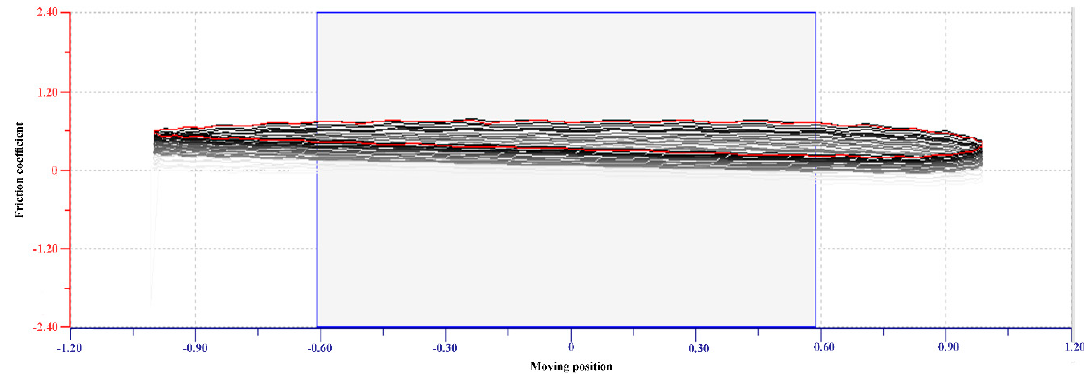
Figure 1. The raw data of the friction coefficient of one condition. The raw data is taken from 1 sequence which is under 0.4 mN load and 0.2 cm/s when the Etafilcon-A lens is sliding in phosphate buffer solution (PBS) for 30 cycles. The x -axis shows Etafilcon-A is moving between the position of − 1.0 mm and 1.0 mm (amplitude of 2 mm), and the y -axis shows the friction coefficient. The rectangle box represents the middle of the cycles, and values of friction coefficient in the rectangle box are averaged as the friction coefficient for this sequence.